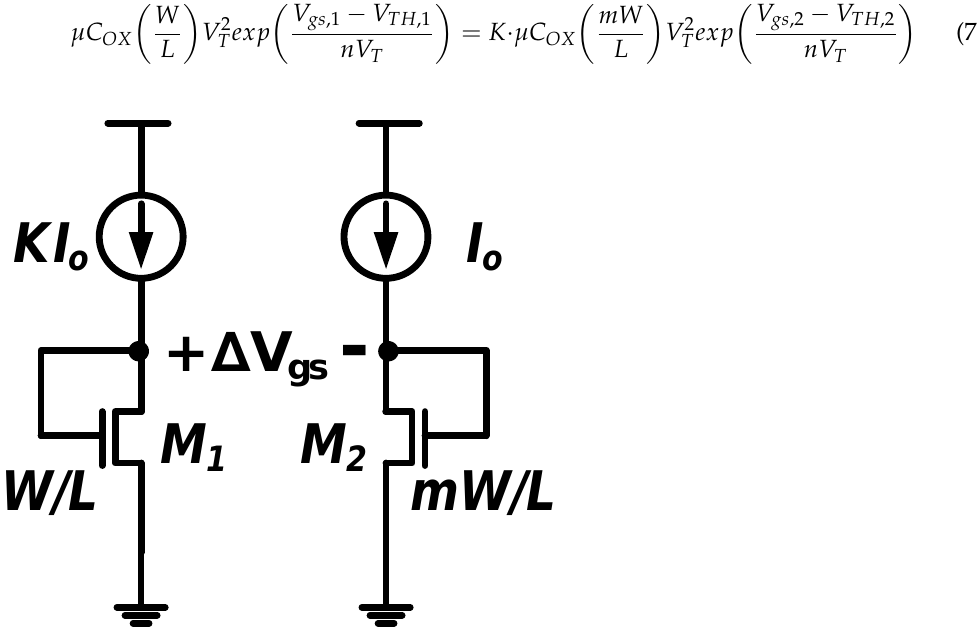
Figure 7. Generation of a PTAT voltage using MOSFETs ( M 1 , M 2 ) working in their subthreshold regions.